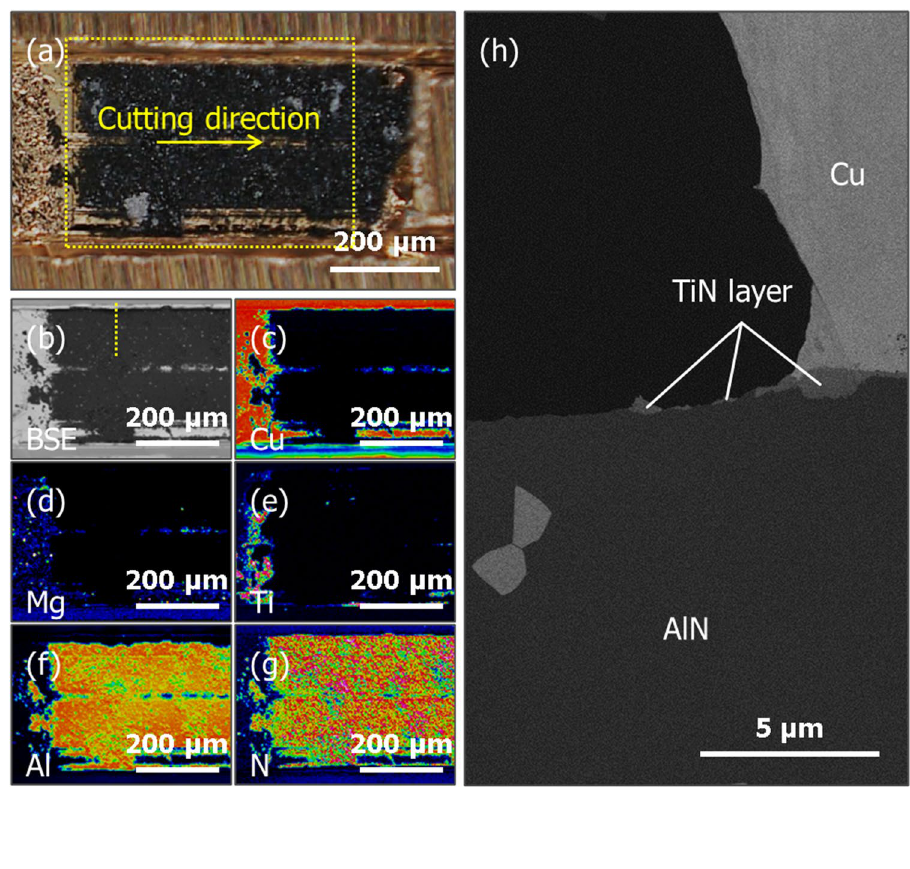
Fig. 9 a Optical image of a specimen bonded at 950 ℃ for 0.5 h after the SAICAS test.